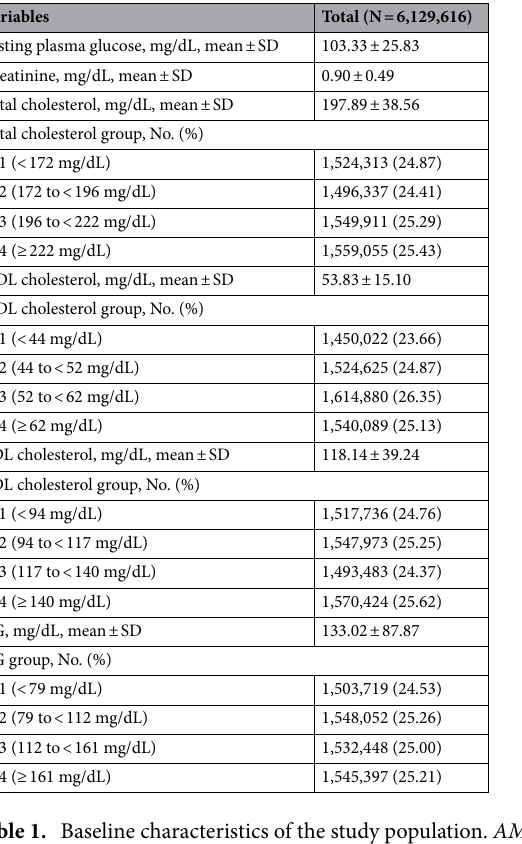
Table 1. Baseline characteristics of the study population. AMD age-related macular degeneration, SD standard deviation, Q quartile, HDL high-density lipoprotein, LDL low-density lipoprotein, TG